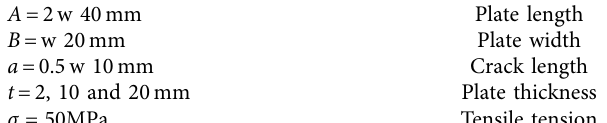
Table 12: Geometry specifications of three-dimensional object including edge crack.